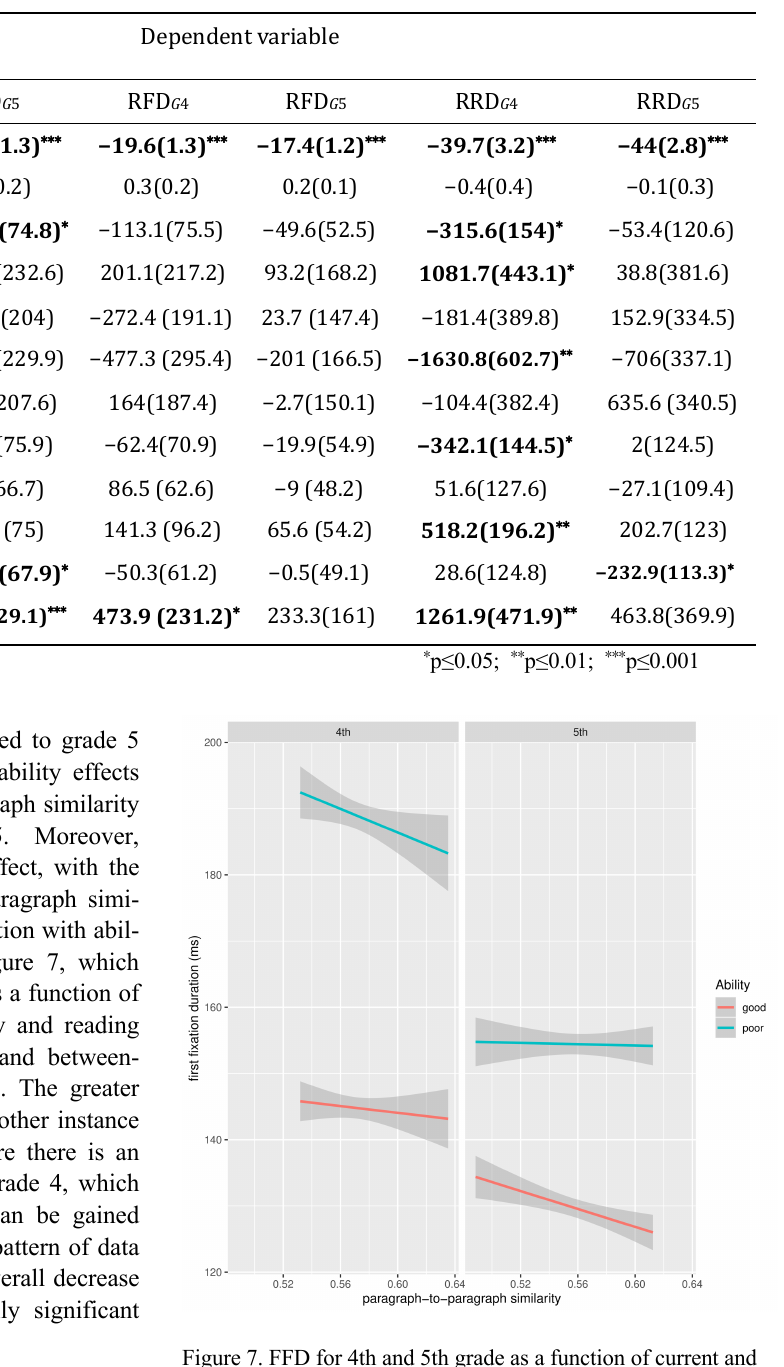
Table 4. Linear mixed model estimates for the three dependent measures across